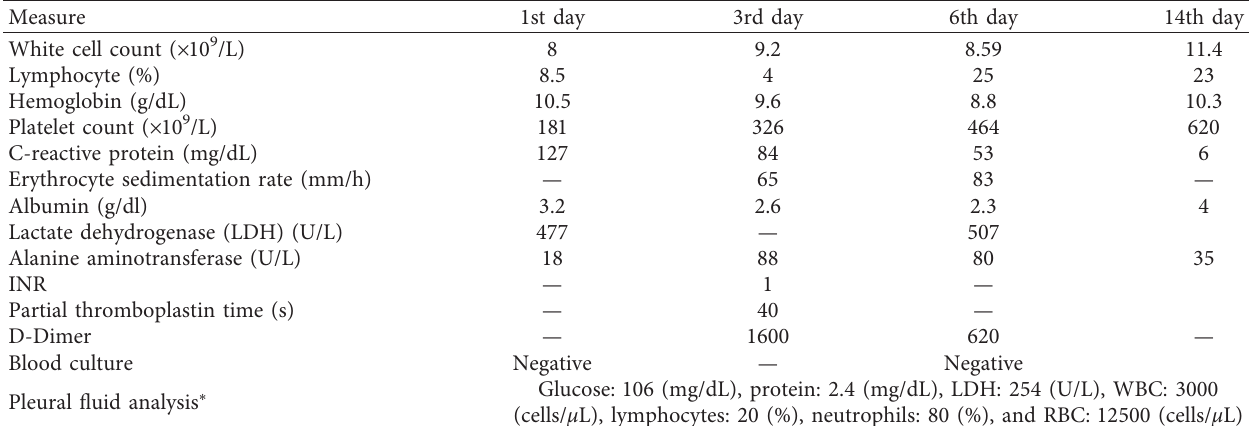
Table 1: Laboratory results in the 1st, 3rd, 6th, and 14th days after